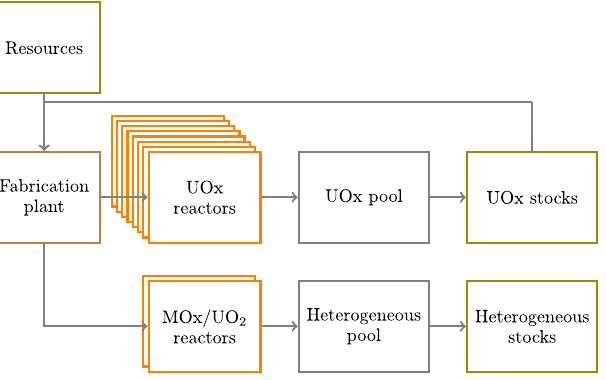
Fig. 11. Representative schematization of the reactor fleet simulated in scenarios.